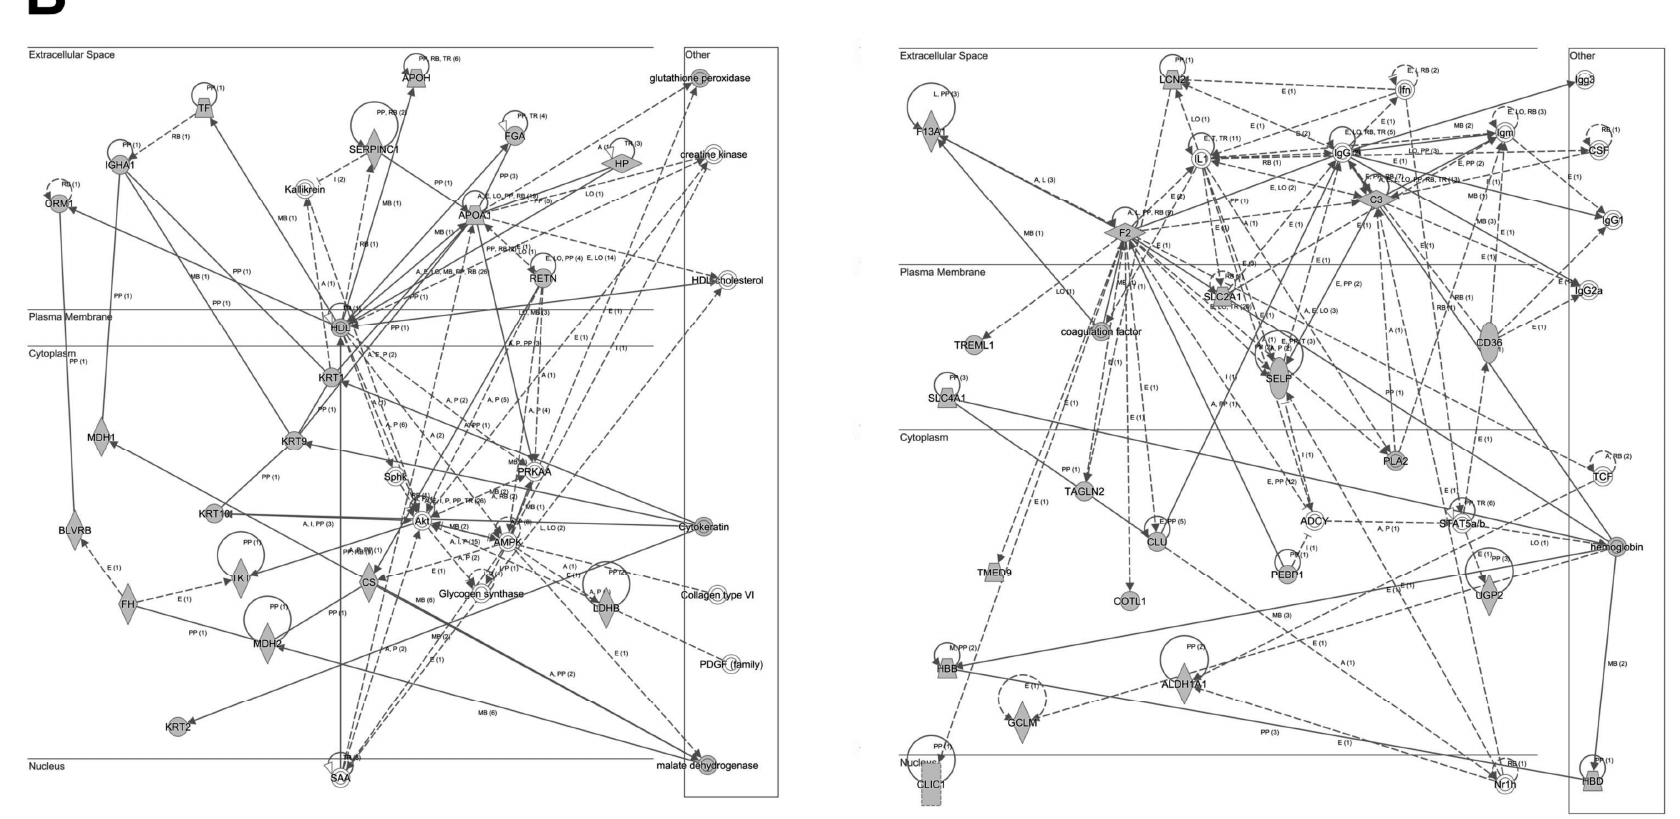
Figure 6. Representation of the relationships between thrombotic proteins characterized in this study: TCP complex ( A ), and lipid metabolism ( B ). Continuous lines represent direct interactions, whereas discontinuous lines correspond to indirect interactions. Continuous and discontinuous lines represent direct and indirect interactions respectively. The complete legend may be found at http://ingenuity.force.com/ipa/articles/Feature_Description/Legend.